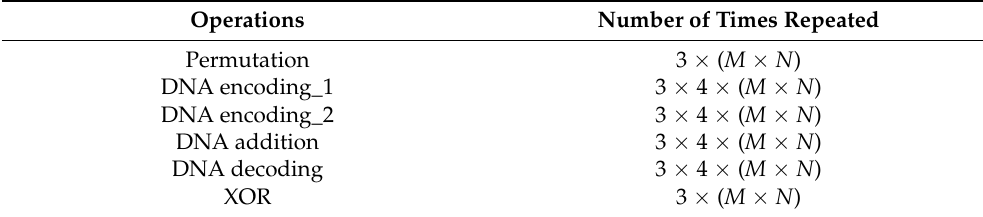
Table 11. Computational complexity of the proposed scheme.